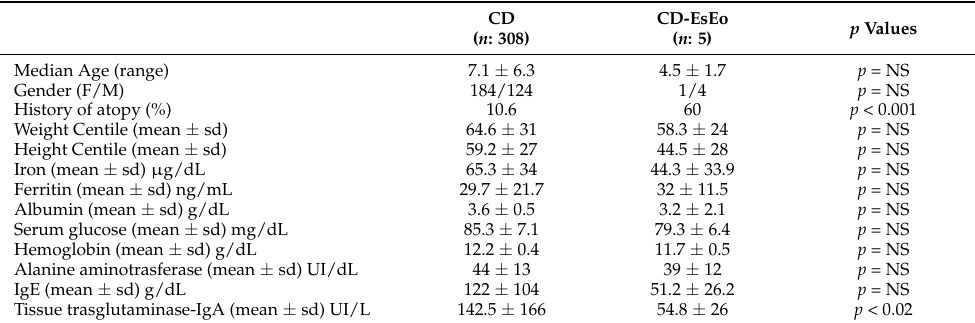
Table 2. Auxological, nutritional, biochemical and hematological parameters of children with celiac disease vs. children with celiac disease and esophageal